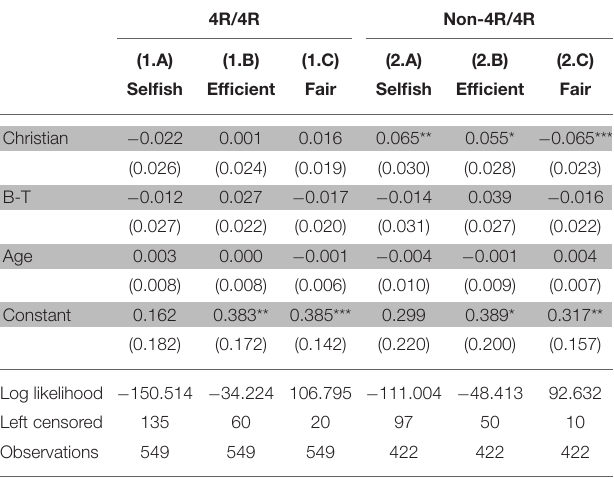
TABLE 4 | Effects of religion split by genotype in